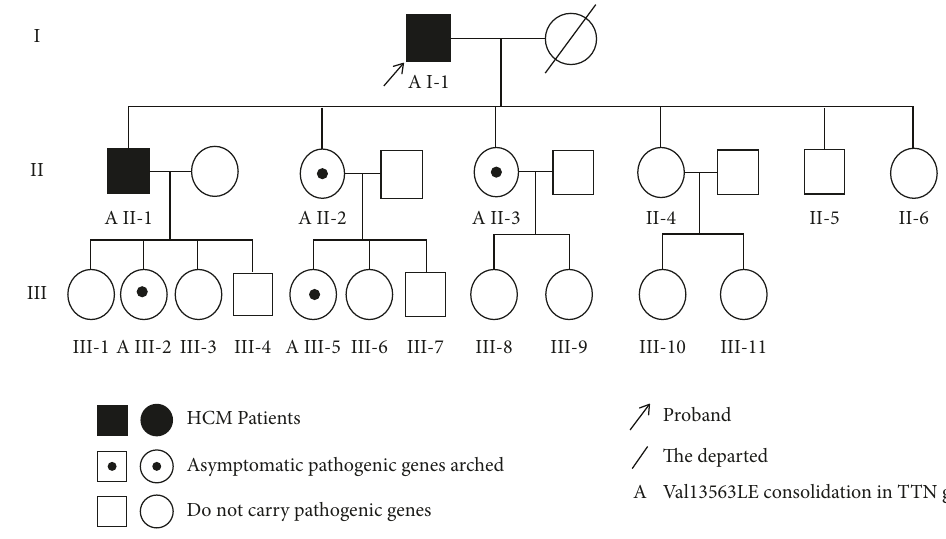
Figure 1: Genogram of the carrier with mutations in the TTN pathogenic